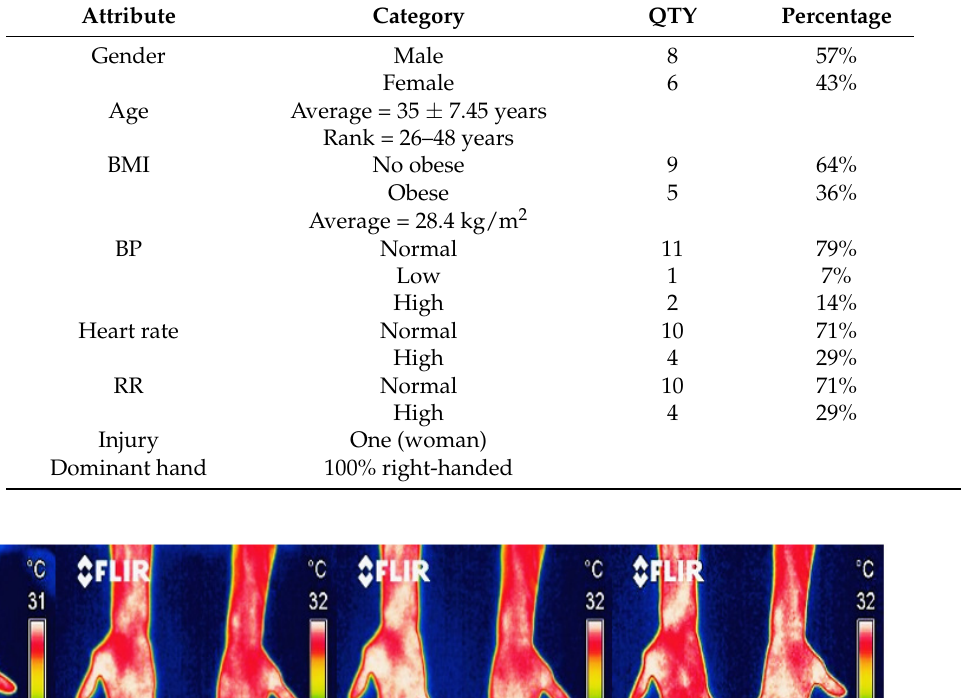
Table 3. Demographic characteristics from the tolex area.